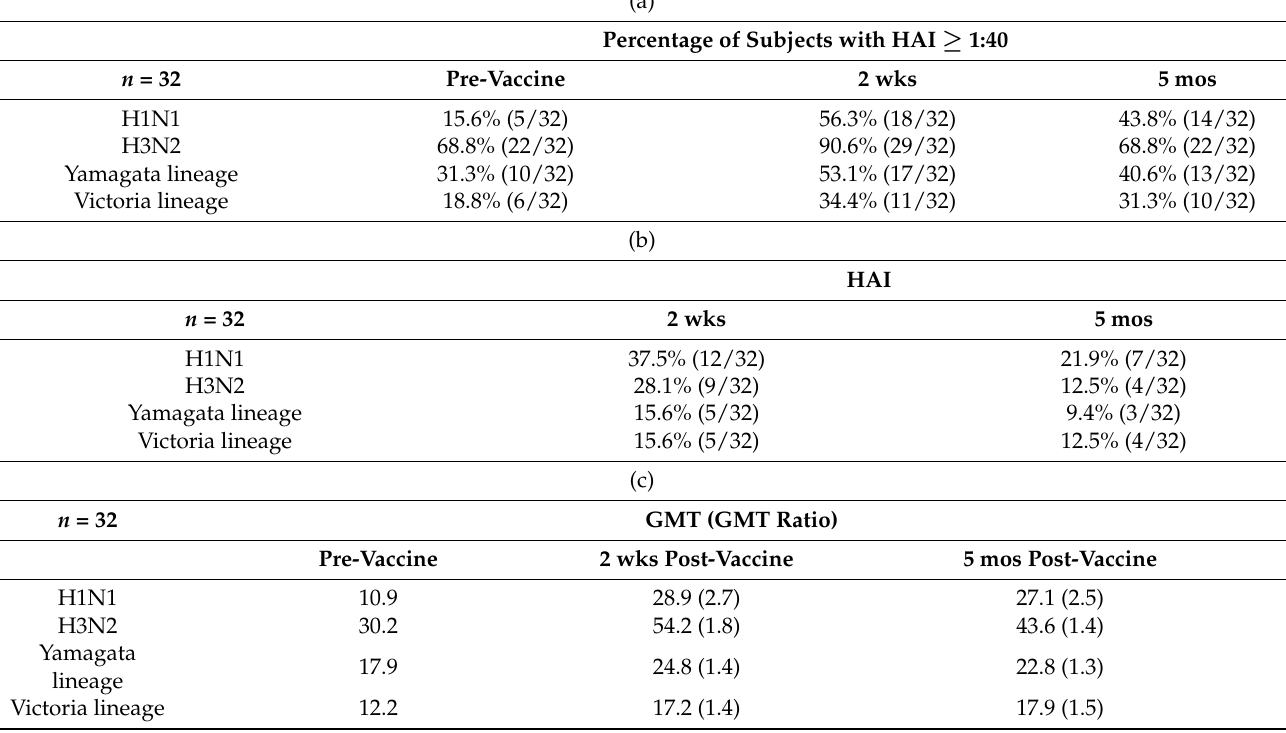
Table 3. Evaluation based on the criteria of the EMA guidelines: (a) percentage of subjects with HAI titers of ≥ 1:40; (b) percentage of subjects with HAI titers of <1:10 before vaccination and ≥ 1:40 after vaccination, or with HAI titers of ≥ 1:10 before vaccination and an increase of at least 4-fold after vaccination; (c) GMT ratios between post-vaccination GMTs and pre-vaccination